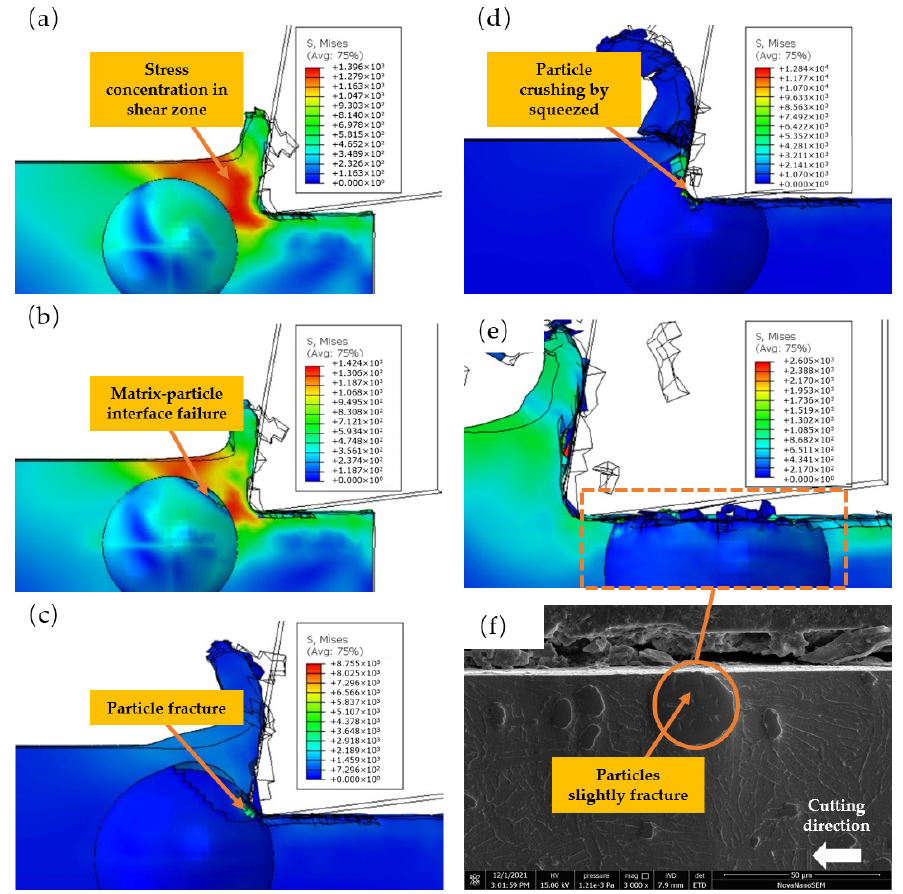
Figure 9. Simulated cutting process of particle below cutting path: ( a ) stress concentration near matrix-particle interface; ( b ) matrix-particle interface failure; ( c ) tool contact with TiC particle; ( d ) TiC particles are broken by tool extrusion; ( e ) simulation results of slightly fractured TiC particles; and ( f ) test results of slightly fractured TiC particles.